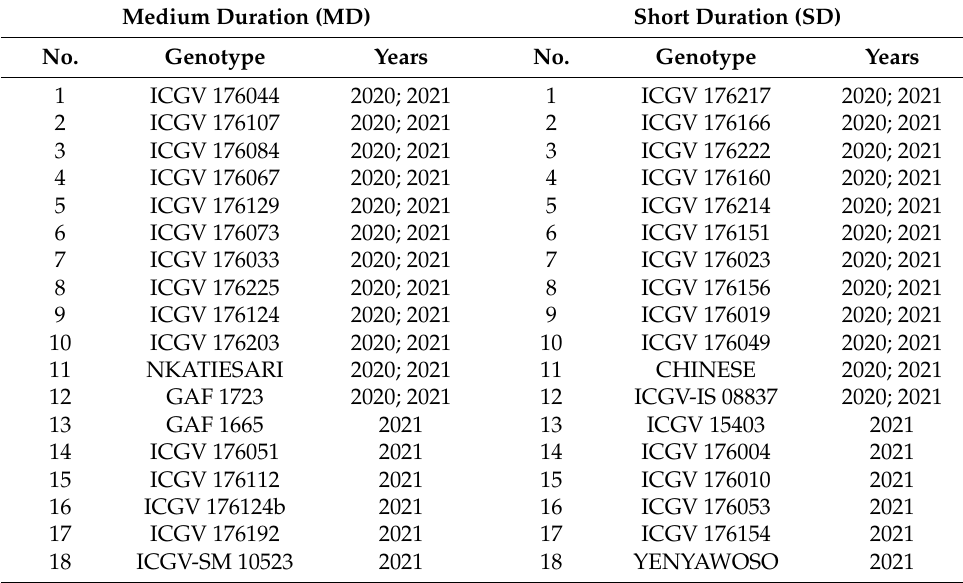
Medium Duration